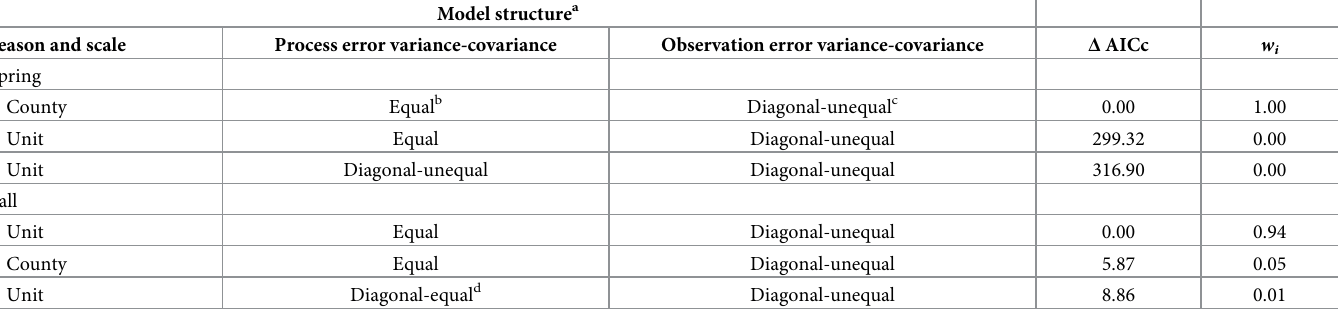
Table 2. Results of model selection analyses to evaluate support for different hypothesized spatial scales of wild turkey hunter population dynamics for spring (Spring) and fall (Fall) hunting seasons in southern